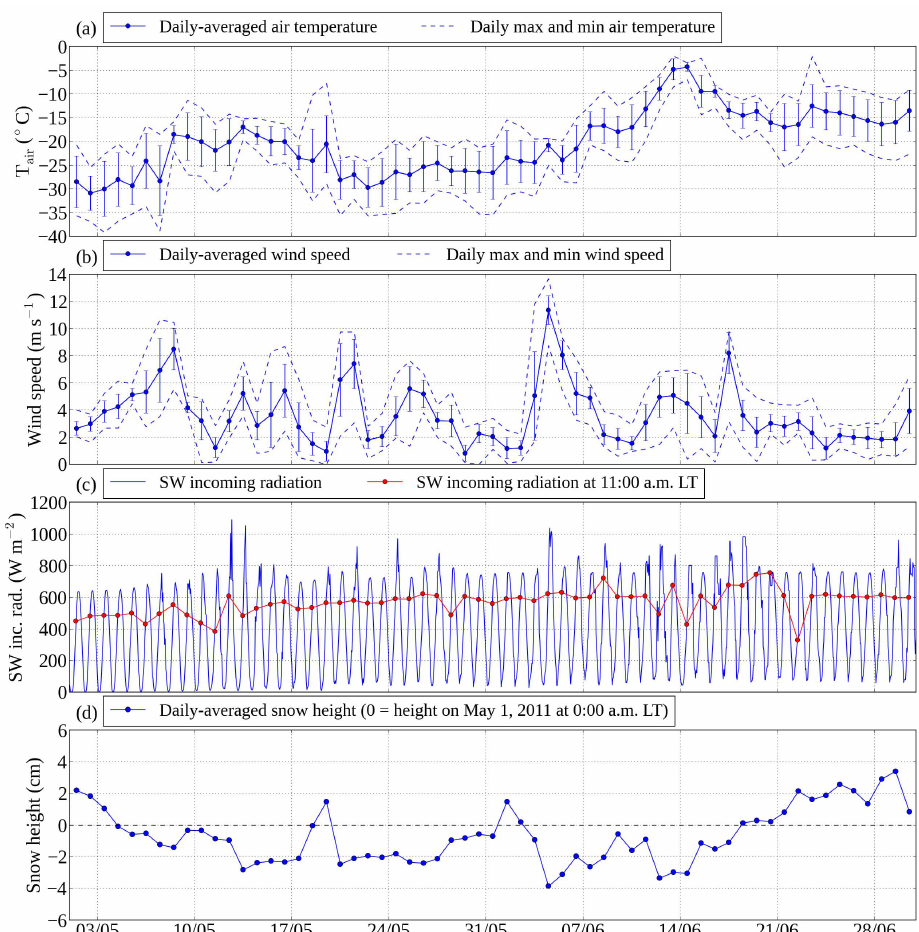
Fig. 1. Meteorological data collected in May and June 2011 by instruments placed on the Summit AWS. (a) Daily average (solid line) and daily maximum and minimum (dashed lines) air temperature at 3.7m above snow. (b) Daily average (solid line) and daily maximum and minimum (dashed lines) wind speed at 3.7m above snow. (c) Hourly short-wave incoming solar radiation; values at 11:00LT are also highlighted. (d) Daily averaged snow height since 1 May 2011 at 00:00LT. Error bars in the top two panels correspond to one standard